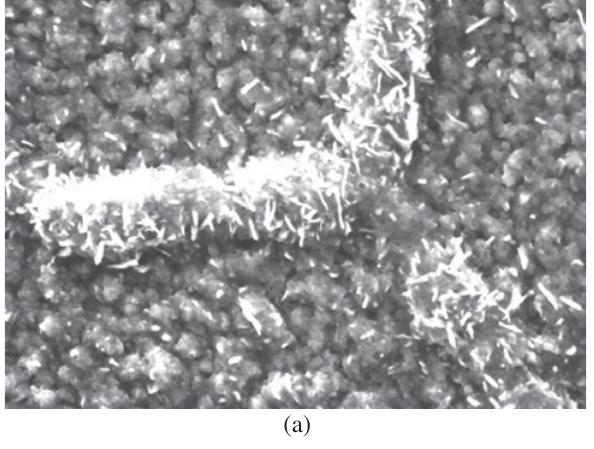
-H O for 50 h (275×). 2 2